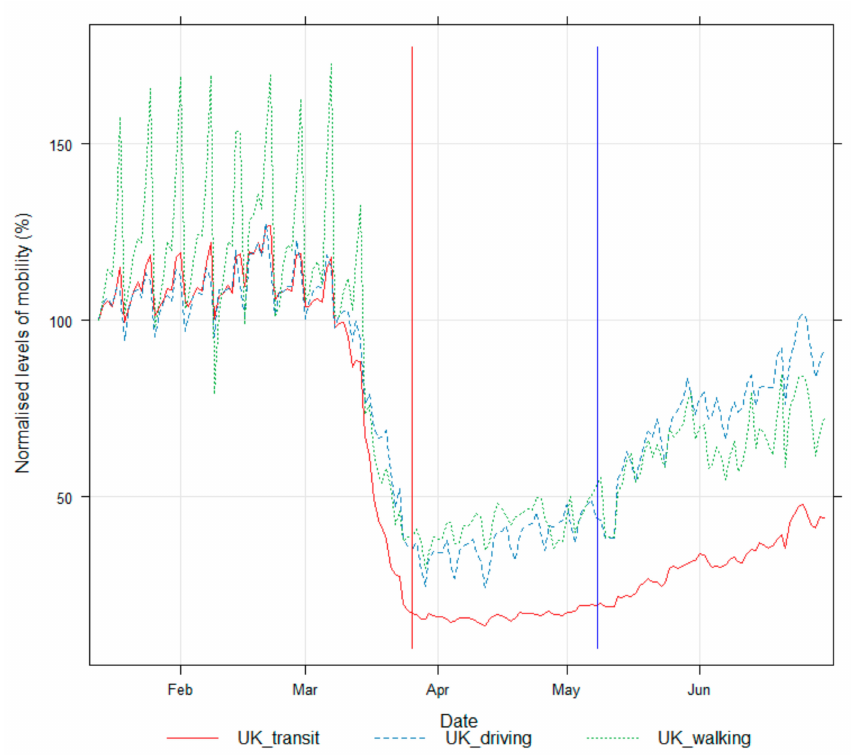
Figure 3. Changes in mobility data (%) in the UK during the lockdown period. The vertical red and blue lines show the start and end of the lockdown period,